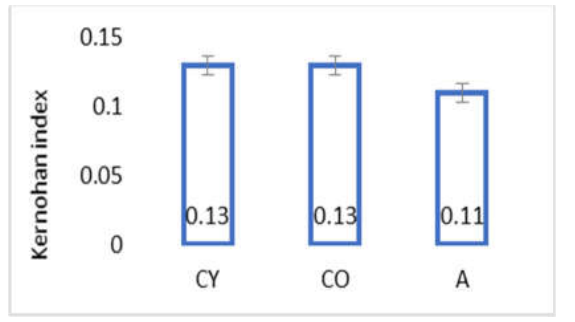
Figure 1. Kernohan index of coronary arteries of the studied groups.